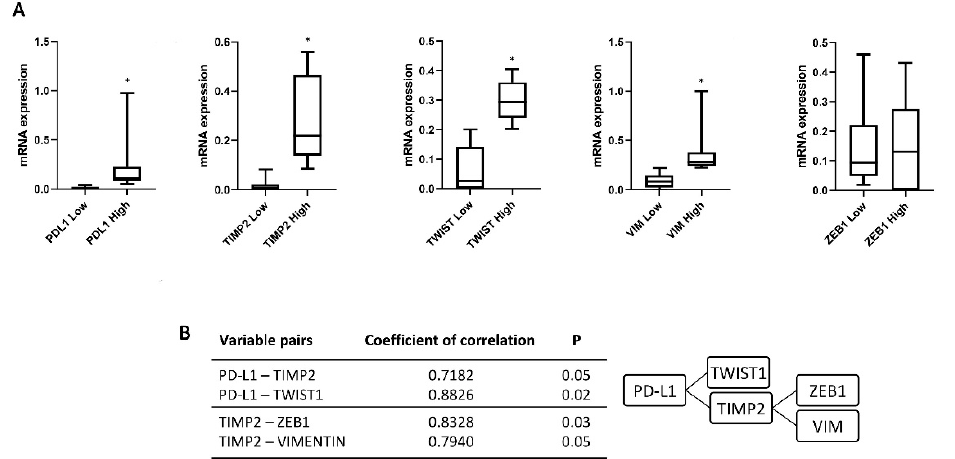
Figure 3. Expression of PD-L1, TIMP2, TWIST1, ZEB1 and VIM in CTCs isolated from NMIBC patients. ( A ) The expression was evaluated by ddPCR in NMIBC patients stratified according the recurrence at the first follow up. Expression values are presented as median with interquartile ranges (boxplot). p value was based on the Mann-Whitney U test, * p < 0.0001. ( B ) Correlation index evaluated for PD-L1-TIMP2 , PD-L1-TWIST1 , TIMP2-ZEB1 and TIMP2-VIM variable pairs.